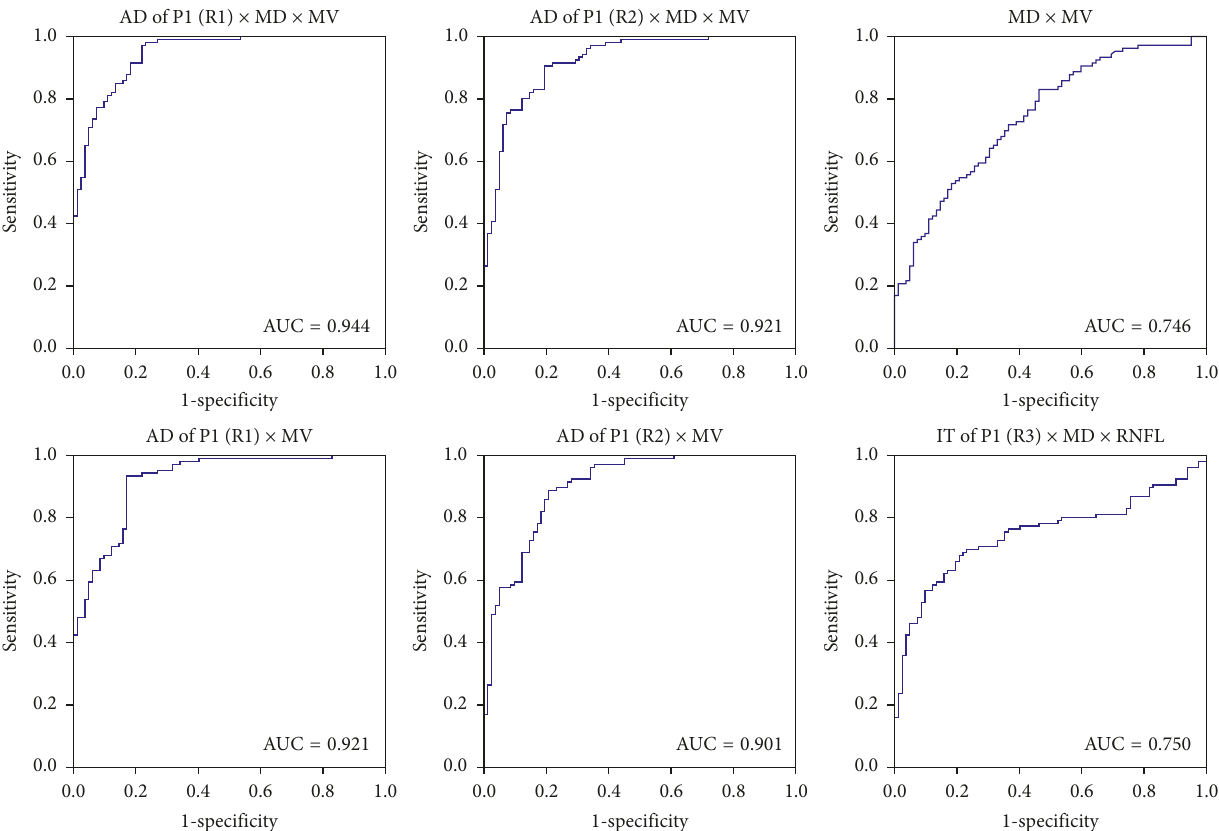
Figure 2: ROC curves of different combinations of visual function and structure parameters for discriminating Parkinson’s disease. AD amplitude density; IT implicit time; R1 ring1; R2 ring2; R3 ring3; MD mean deviation of visual field, MRT (cid:31) (cid:31) (cid:31) (cid:31) (cid:31) (cid:31) thickness; MV macular volume; RNFL retinal nerve fiber (cid:31) (cid:31)